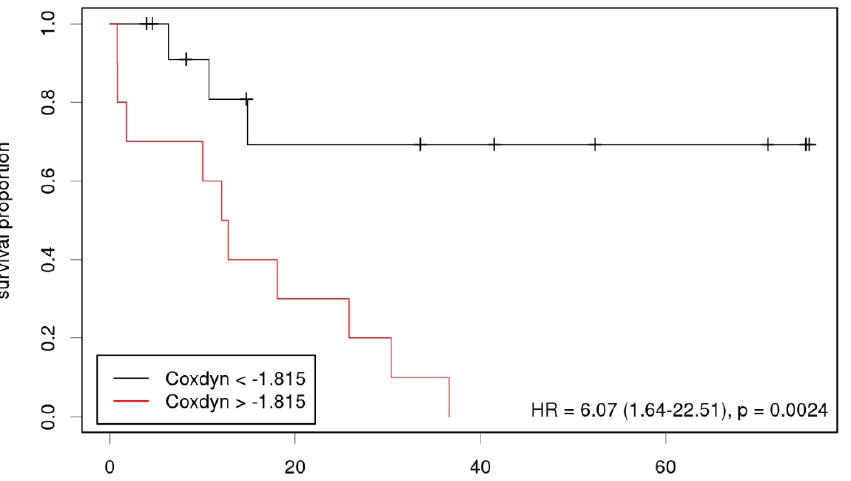
Figure 6. Kaplan–Meier plot showing low- and high-risk groups according to multiparametric Figure 6. Kaplan – Meier plot showing low- and high-risk groups according to multiparametric com-